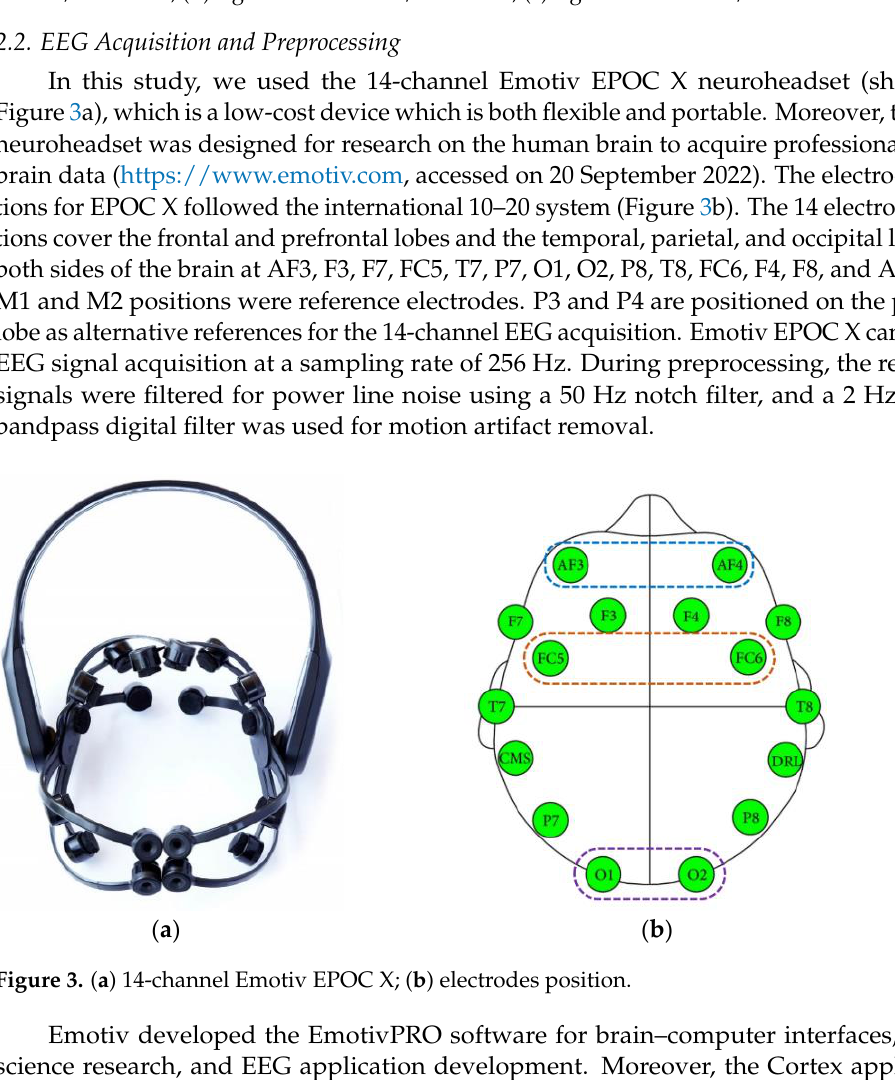
Figure 3. ( a ) 14-channel Emotiv EPOC X; ( b ) electrodes position.